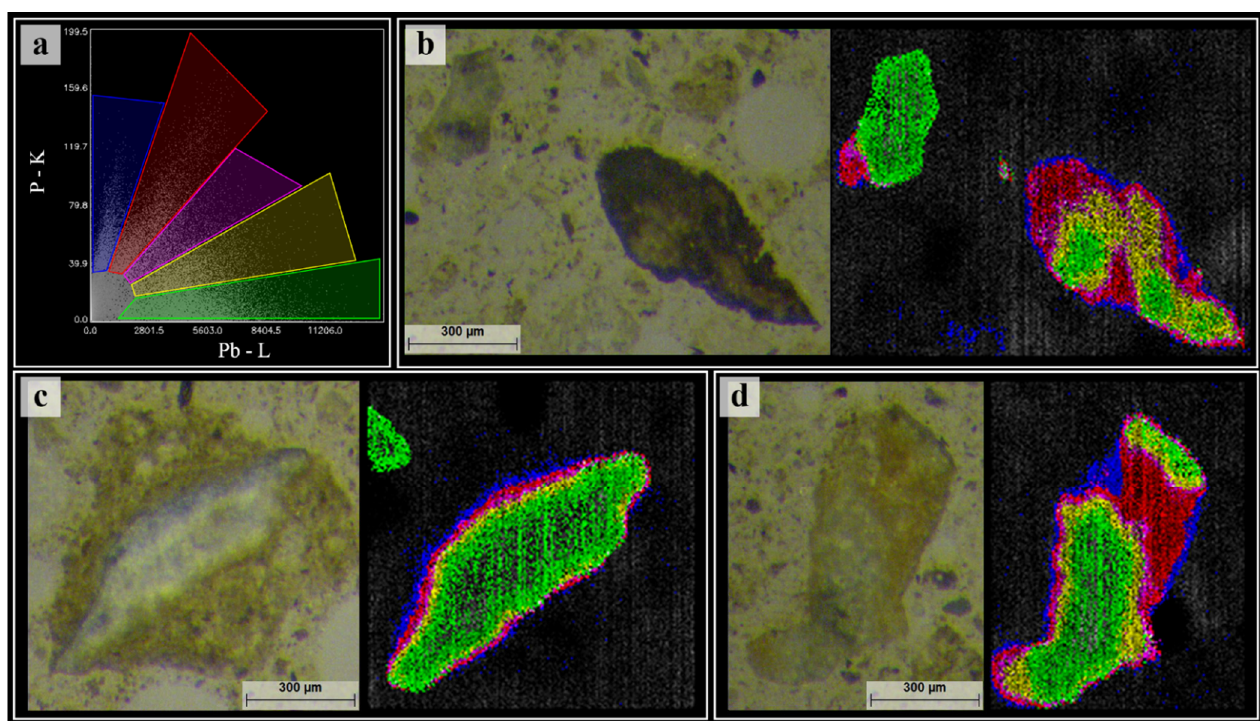
Figure 2. ( a ) P (K fluorescent signal) vs. Pb (L fluorescent signal) scatterplot obtained using spectral µXRF deconvolution data of ( b – d ) particles. ( b – d ) particles micrographs ( left ) and related correlation maps ( right ) coloured according to the different P/Pb correlations identified through the scatterplot ( a )).